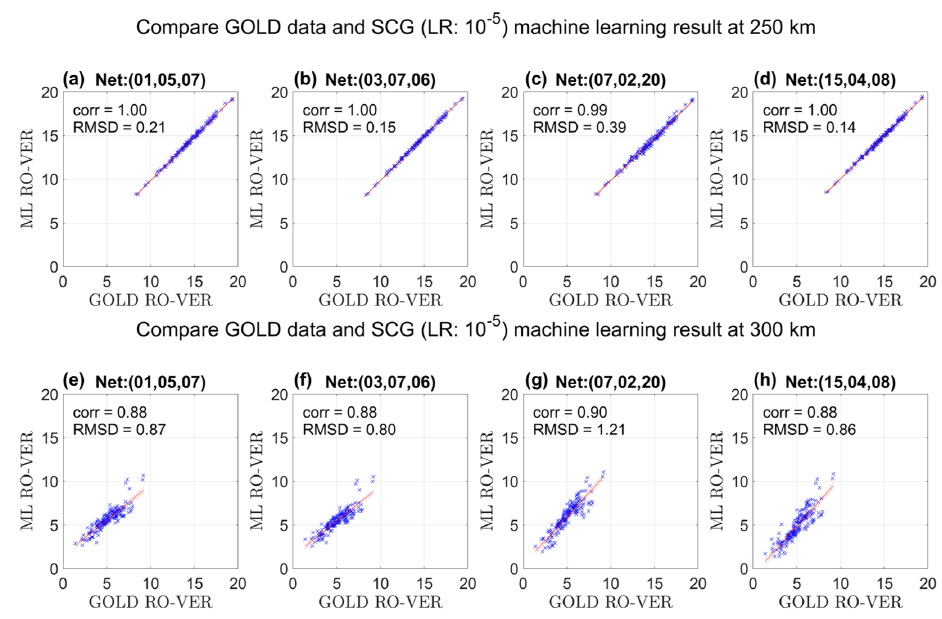
Figure 5. Similar to Figure 4, but trained with SCG algorithm. From left to right, the nets with the number of neurons in three HDLs are (01, 05, 07), (03, 07, 06), (07, 02, 20), and (15, 04, 08) at